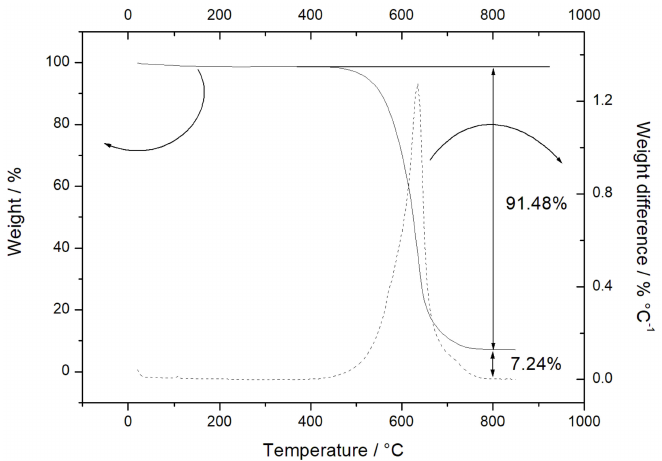
Figure 1. TGA curve (solid line) and weight difference (dash line) for the as-prepared Sn-RGO